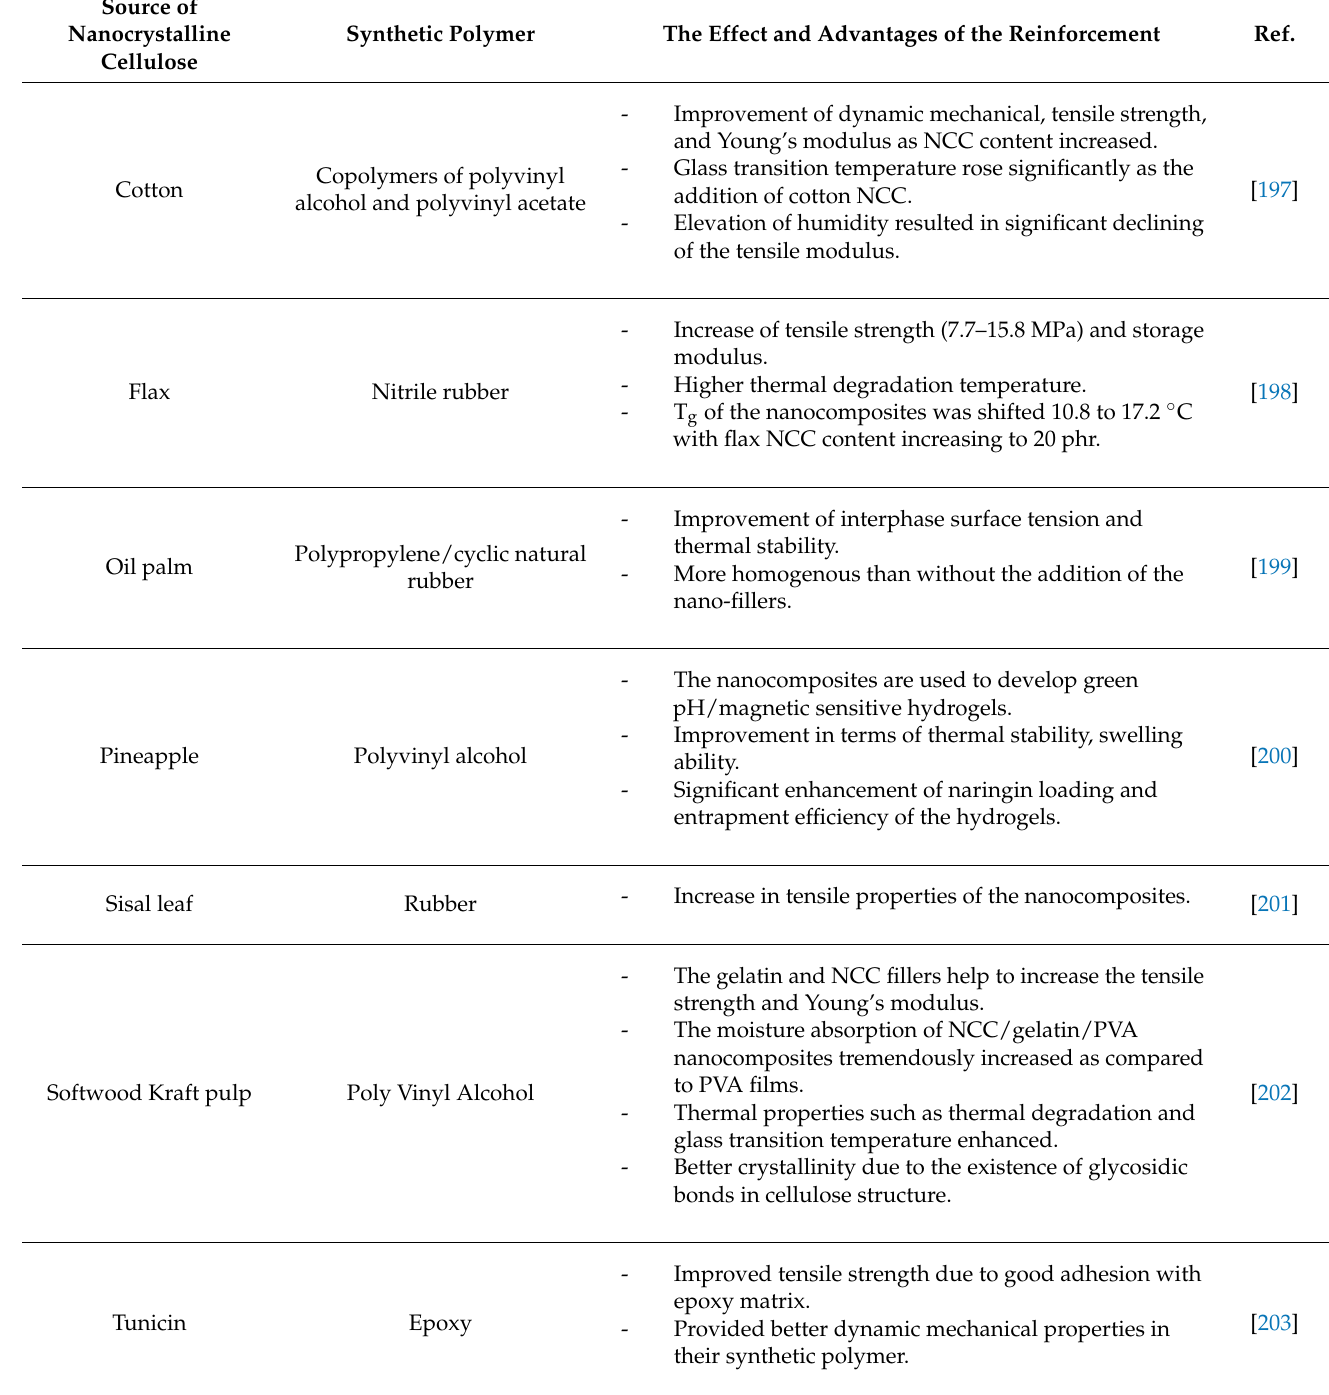
Table 1. Illustration of the effect of nanocrystalline cellulose on synthetic polymer